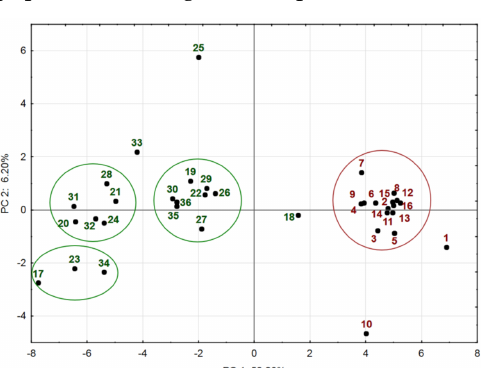
Figure 1. PCA1 score plot model representing the accumulation of phenolic compounds in Achillea millefolium plant materials from Turkey (No. 1–16) and Lithuania (No. 17–36) populations. In- florescence, leaf, and stem datasets were pooled together and used for PCA. Scores marked and outlined in brown indicated Turkish populations; scores marked and outlined in green indicated Lithuanian